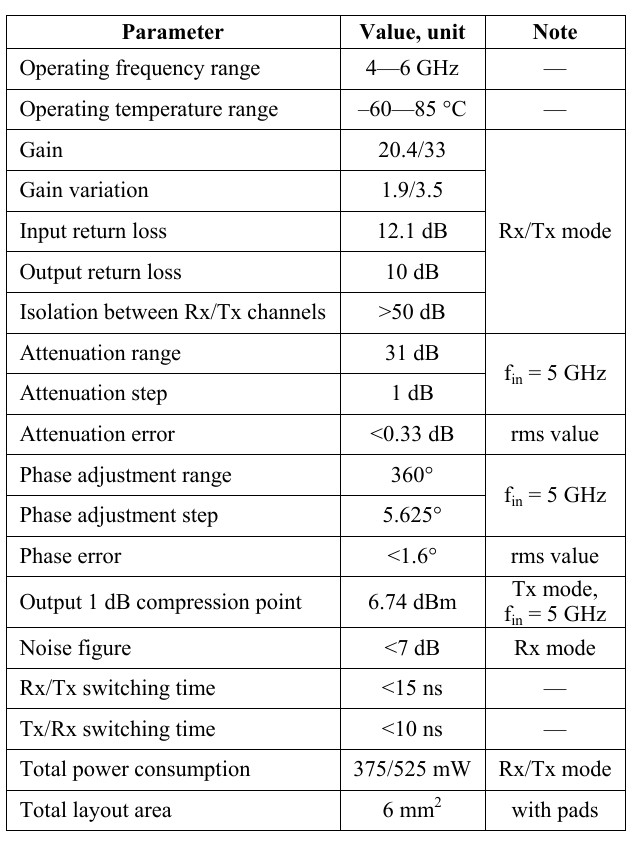
Table 1. Parameters of the designed Core